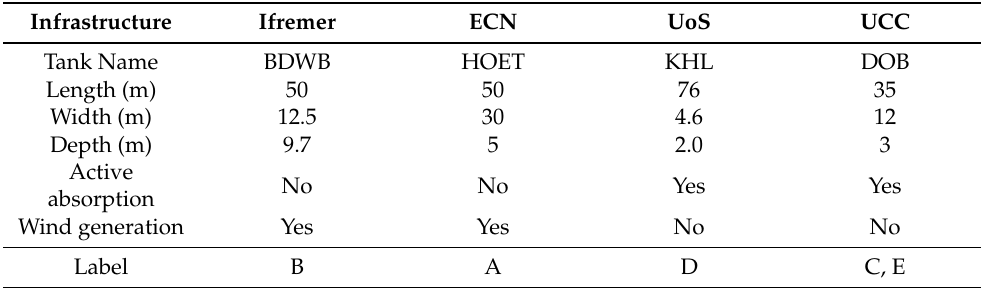
Table 1. Features of the test facilities. ‘Label’ indicates how the datasets from these facilities are referred to